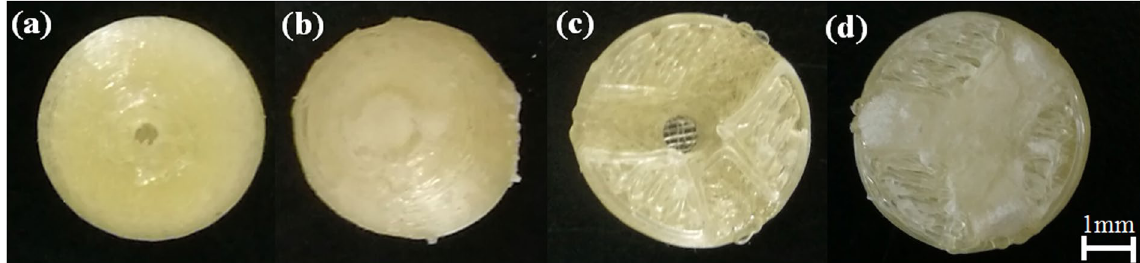
Figure 3. The structure of the tablet with Cylinder model. ( a ) tablet shell with a hole, ( b ) tablet after injection of the drug molecule, ( c ) cross section of tablet shell before injection, ( d ) cross section of tablet shell after injection.